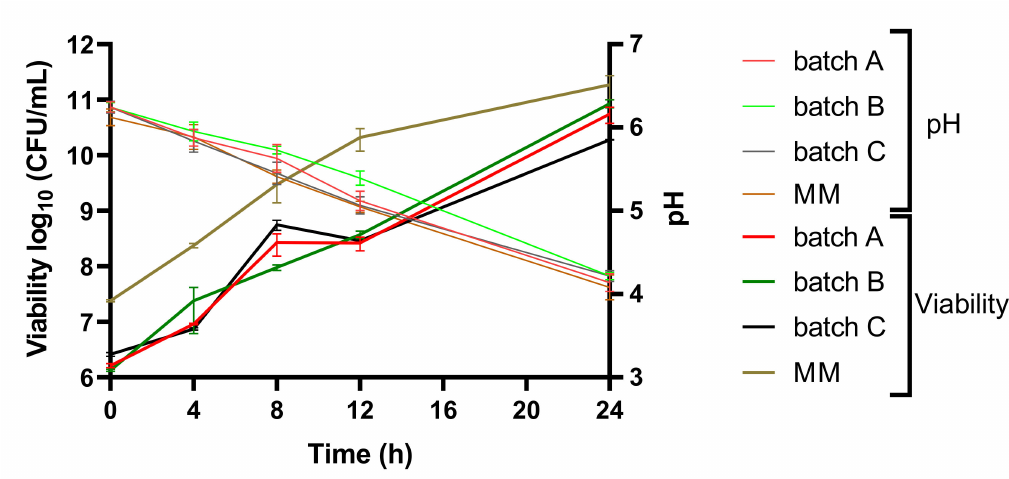
Figure 2. Cell viability (spread plate method) and pH profile of the fermentations at the three di ff erent substrate concentrations (wheat and soy-flour) and MM for 24 h with the cocultures. Values for LAB viable cell growth and pH are displayed as mean values ± SD, log10 CFU / mL, n = 3, GraphPad Prism Version 8.0.1 (Graph Pad Software, Inc., San Diego, CA, USA); batch A (90% WF + 10% SF addition); batch B (95% WF + 5% SF addition); batch C (100% WF), MM (model media); CFU / mL (colony-forming units / milliliter of